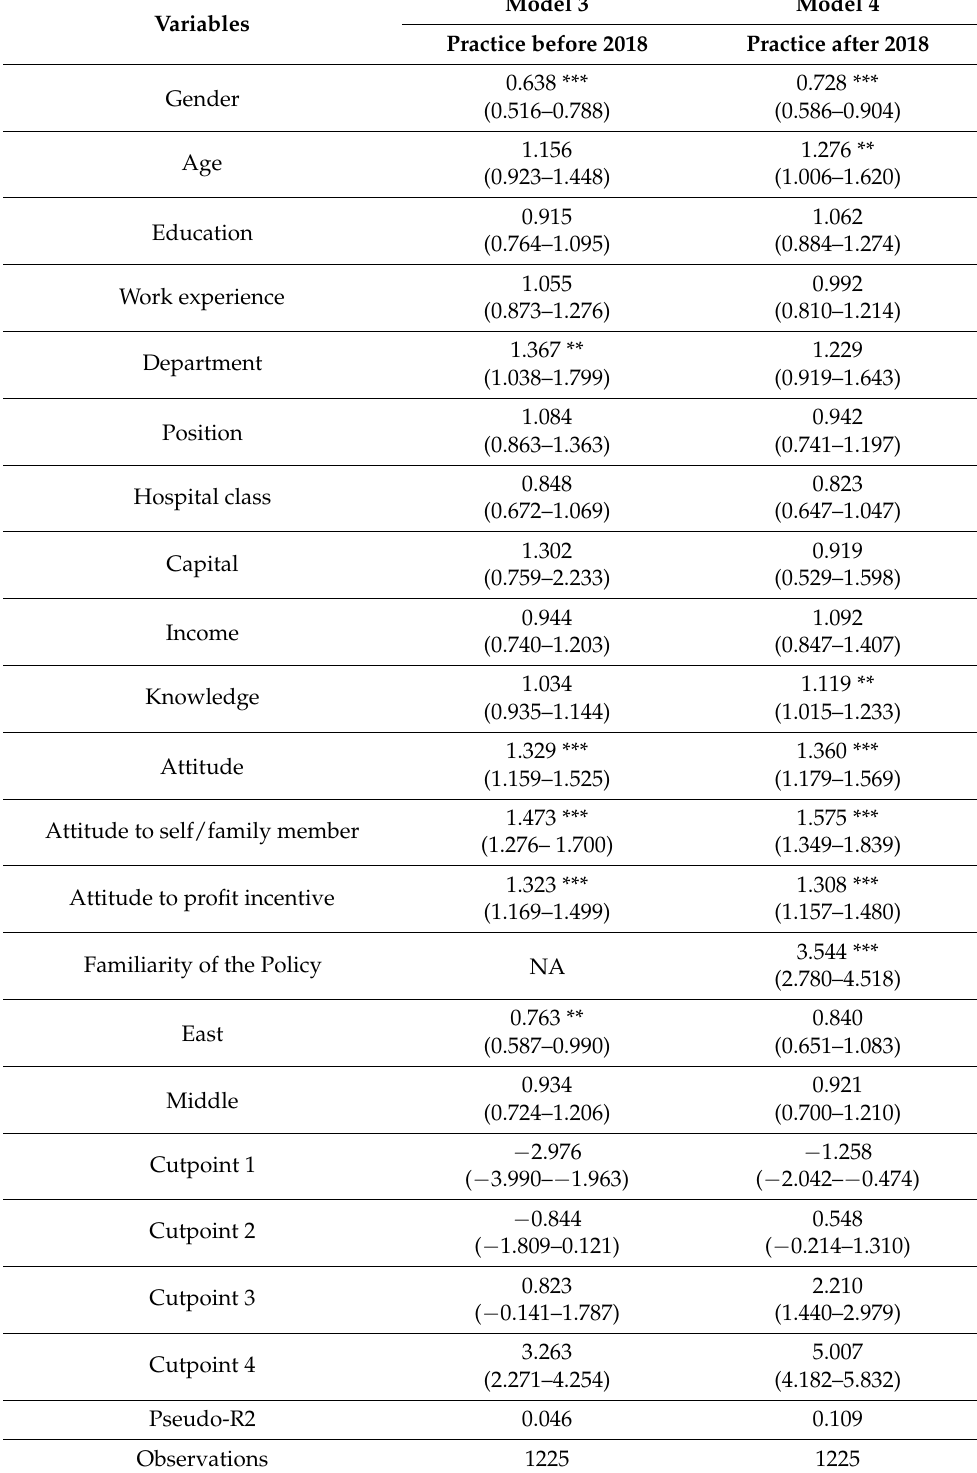
Table 5. Ordered logistic regression analysis of factors associated with physicians prescribing